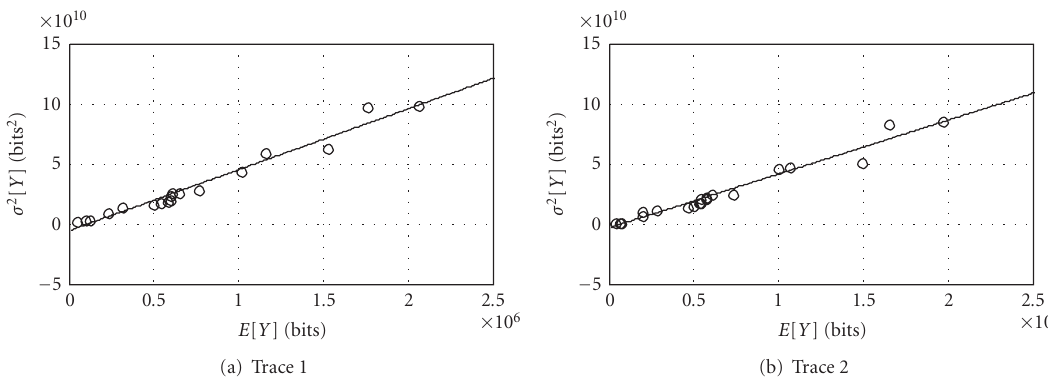
Figure 3: Dependence between mean and variance of aggregated tra ffi c.